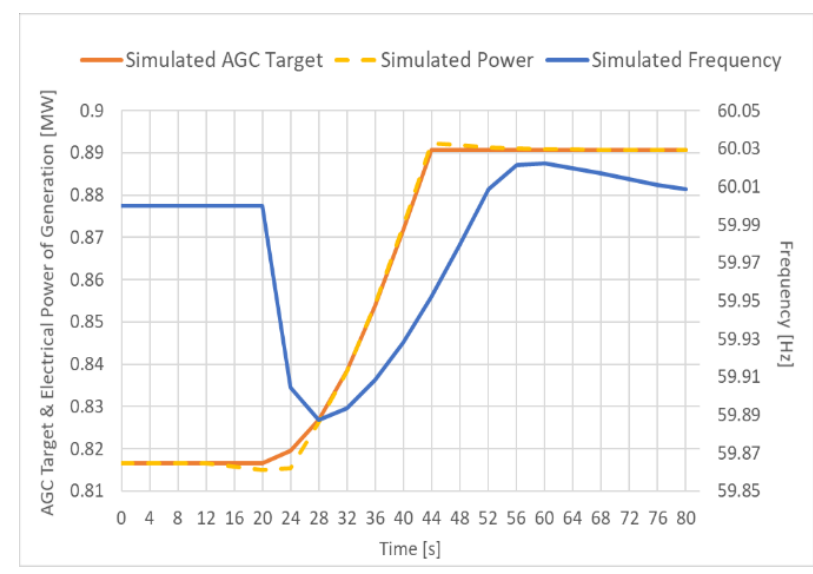
Figure 17. Comparison of the AGC activation time between the measured ( upper ) and simulated ( lower ).